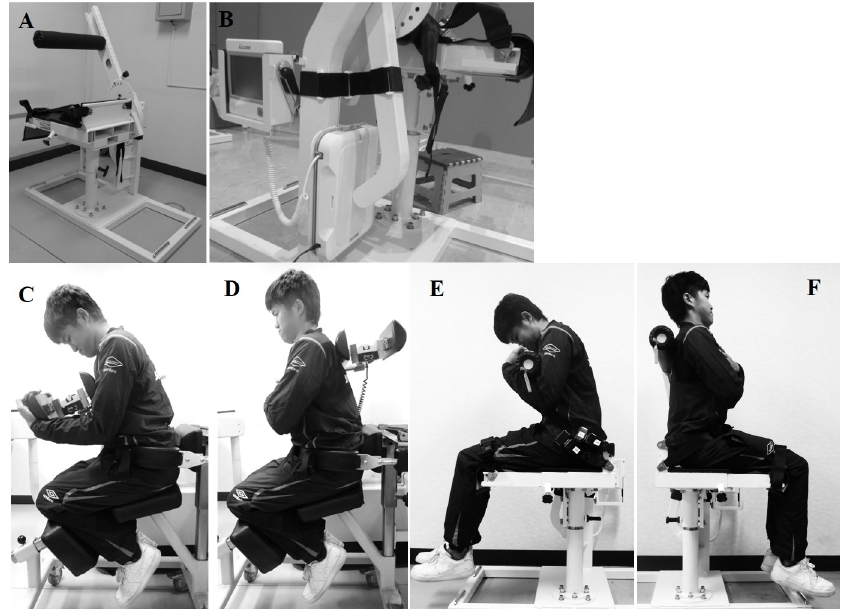
Fig 1. Portable trunk muscle strength measurement instrument. Overall appearance of the portable trunk muscle strength measurement instrument (A). The position on KinCom (B, C) and the portable trunk muscle strength measurement instrument (D,